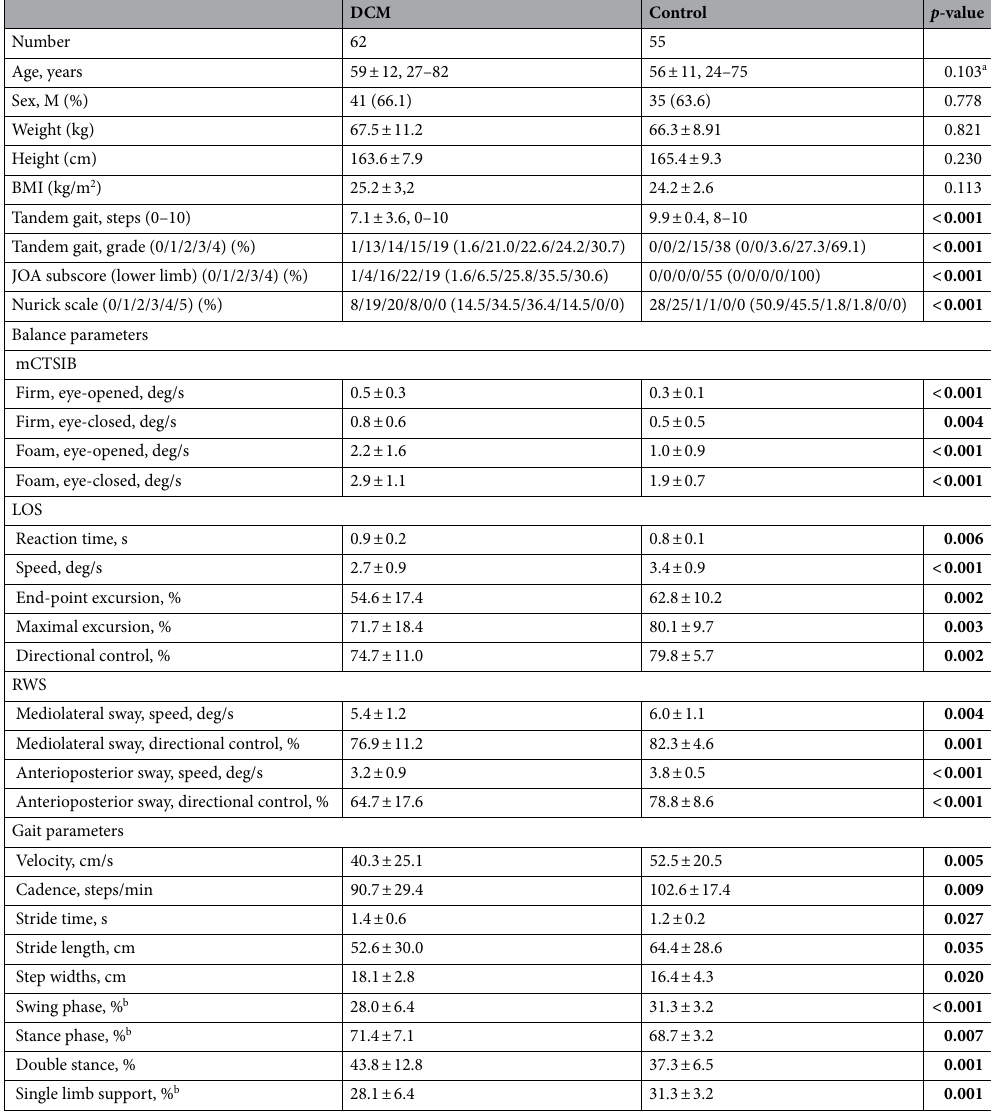
Table 2. Comparisons of clinical features between patients with degenerative cervical myelopathy (DCM) and radiculopathy. a Independent t test was used for age; otherwise, Mann–Whitney U test was applied for continuous variables. Chi-squared test was performed for sex; otherwise, Fisher’s exact test was applied for categorical variables. b These parameters are calculated as the average of the left and right. JOA Japanese Orthopedic Association, mCTSIB modified clinical test of sensory integration and balance, LOS limits of stability, RWS rhythmic weight